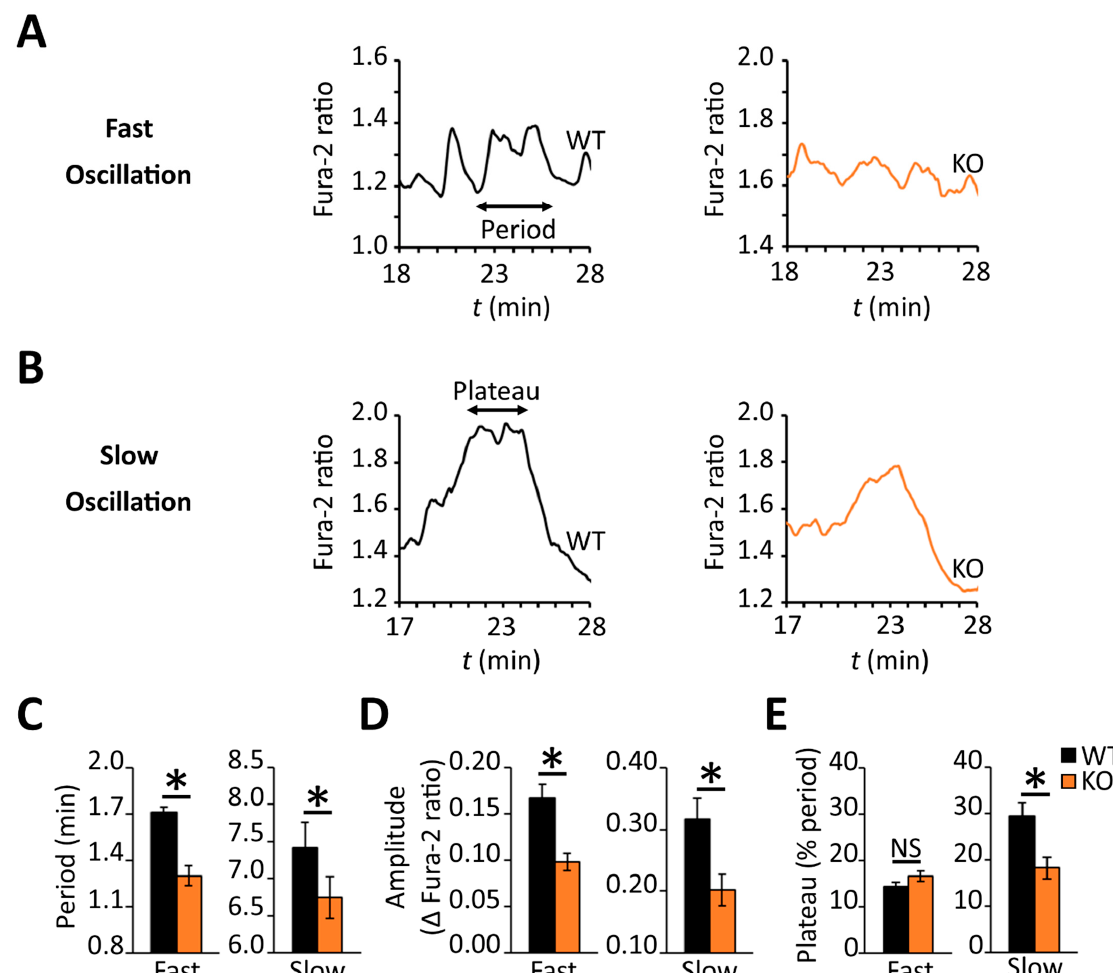
Figure 8. RGS4 promotes increased oscillatory intracellular calcium behavior in dispersed β -cells challenged with glucose. Representative traces of fast-type ( A ) and slow-type ( B ) intracellular calcium oscillations recorded during phase II of the glucose response in dispersed β -cells from WT and RGS4-KO pancreata as in Figure 7 above. The characteristics of the oscillatory behavior for slow and fast oscillations are recorded in panels ( C ), for the period, ( D ) for amplitude, and ( E ), for relative duration of a sustained plateau. In all panels, the data are representative of 180 and 128 fast oscillations and 25 and 48 slow oscillations for WT and KO, respectively. * p < 0.05; [ t -test was applied in panel ( C – E )].